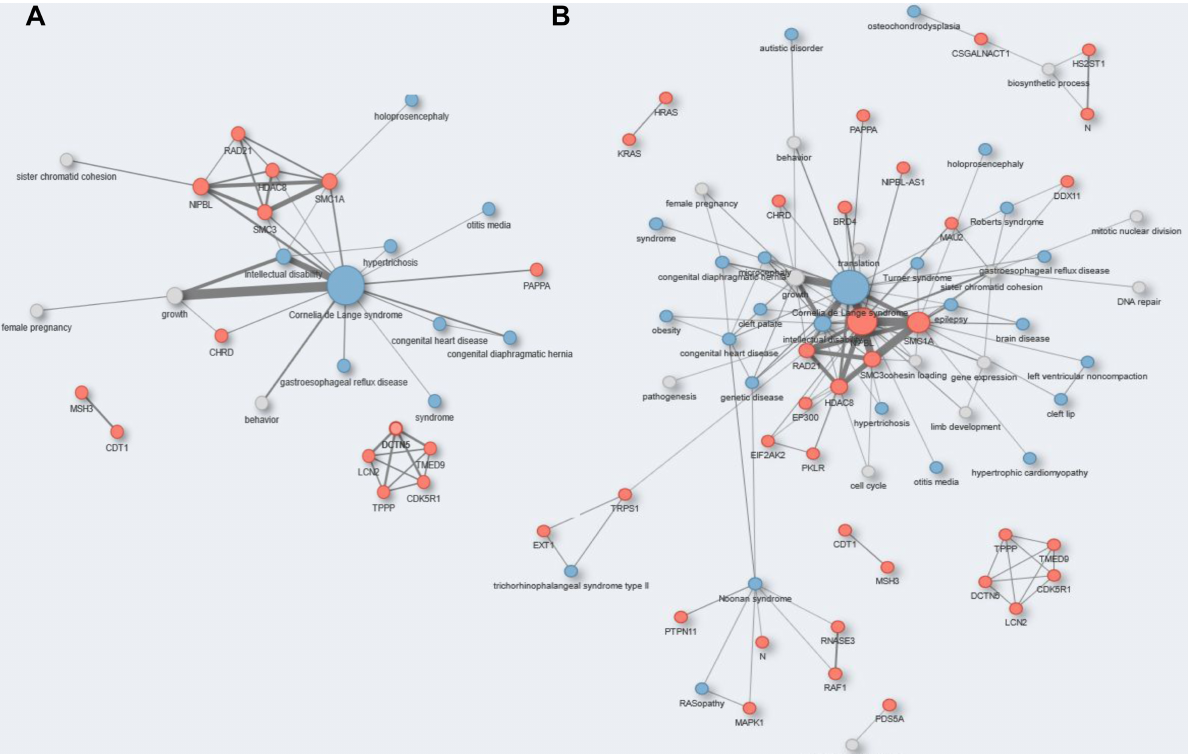
Figure 4. Networks of genes/proteins, GO Biological Processes and DOID diseases generated by Darling query of OMIM ( A ) or OMIM, HPO and DisGeNET compendiums together ( B ) for “Cornelia de Lange”. Entities (264 and 712, respectively) were used to build co-occurrence networks (filter by frequency =